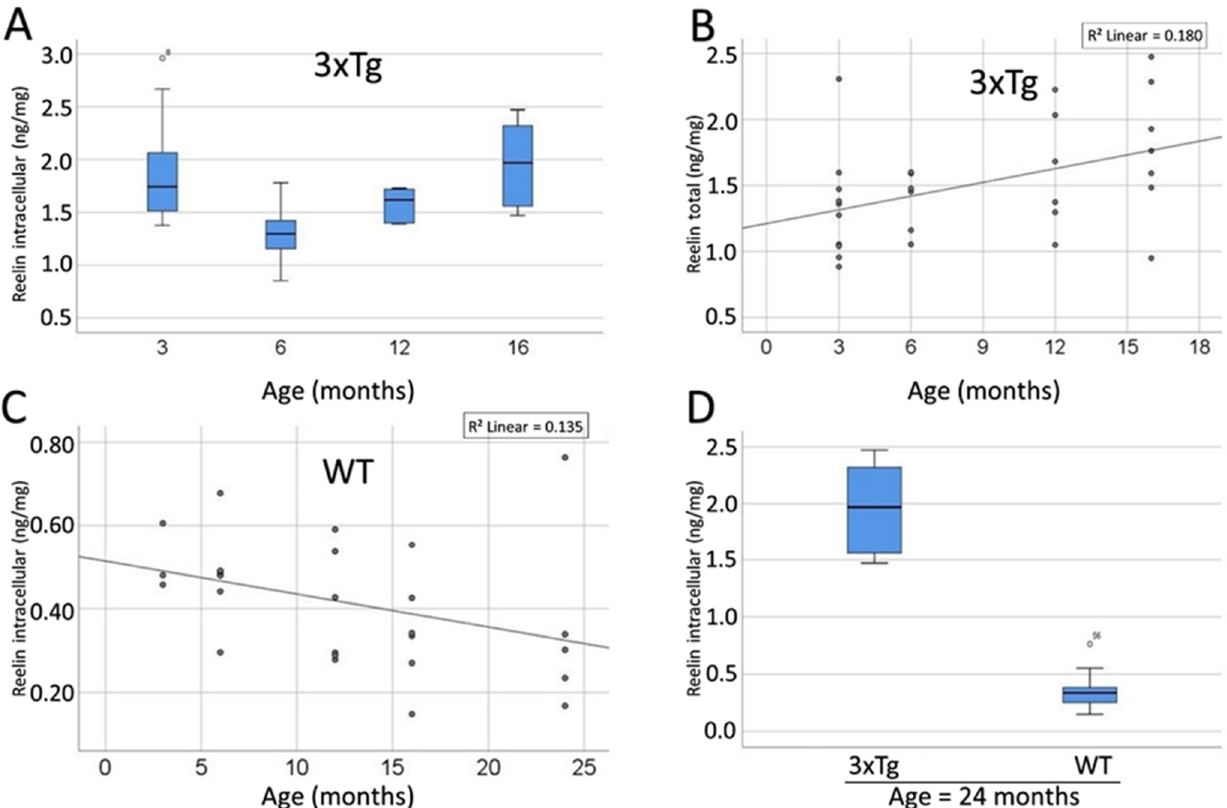
Figure 14. The concentration of Reelin significantly rises over the course of ageing in 3xTg mice, whereas WT animals show a significant decline. ( A ) Boxplot representation of the age-dependent Reelin content within the intracellular fraction of the brains of 3xTg mice (specified in ng/mg). Over- all, a significant difference between the age groups was observed (ANOVA p = 0.023). The detailed comparison of the single groups revealed significant differences between the 3 and 6 month-old animals (Bonferroni-corrected post hoc test: p = 0.049) and between the 6 and 16 month-old mice (Bonferroni-corrected post hoc test: p = 0.049). ( B ) Correlation between age and Reelin content in the TCF in 3xTg mice. This correlation is positive and statistically significant (R = 0.424, p = 0.022). ( C ) Correlation between age and Reelin content in the ICF in WT mice. This correlation is negative and statistically significant (Pearson’s Coefficient: r = − 0.444, p = 0.020). ( D ) Representation of the intra- cellular Reelin content of ≥ 16 month-old mice in dependency of their genotype. 3xTg mice show significantly elevated levels of intracellular Reelin (ANOVA: p = 0.033). ◦ : Indicates data values lying 1.5 to 3× of the IQR away from the mean value. *: Indicates data values lying >3× of the IQR away from the mean value.